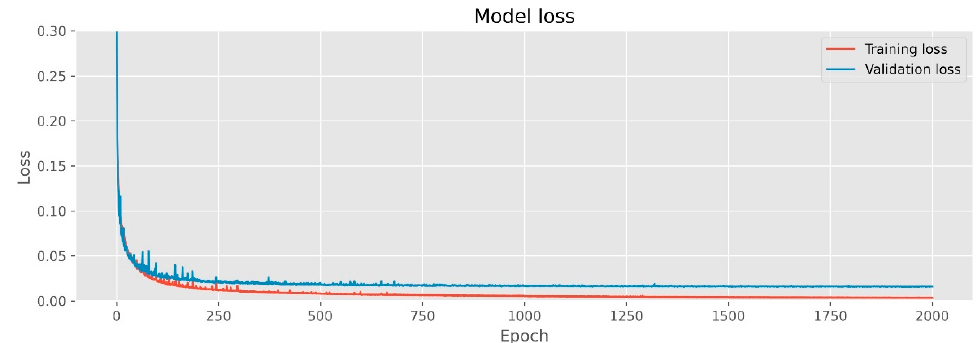
Figure 6. Training loss and validation for the proposed network based on 3D and 2D CNN.